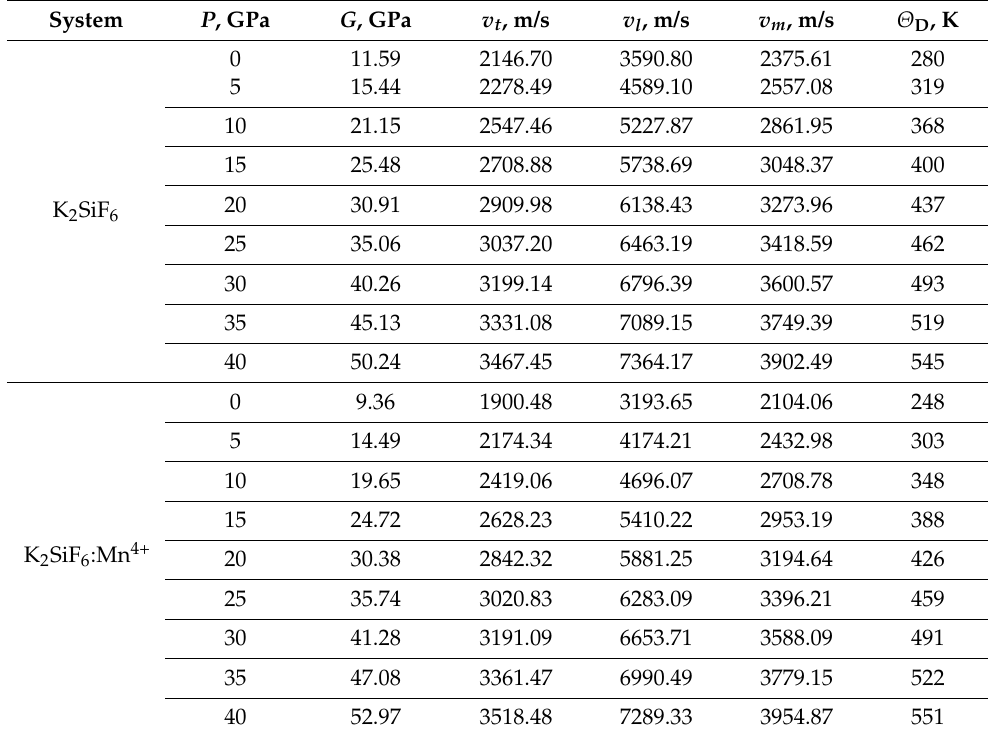
Table 3. Calculated shear moduli, sound velocities and Debye temperatures for the non-doped and Mn 4+ -doped K 2 SiF 6